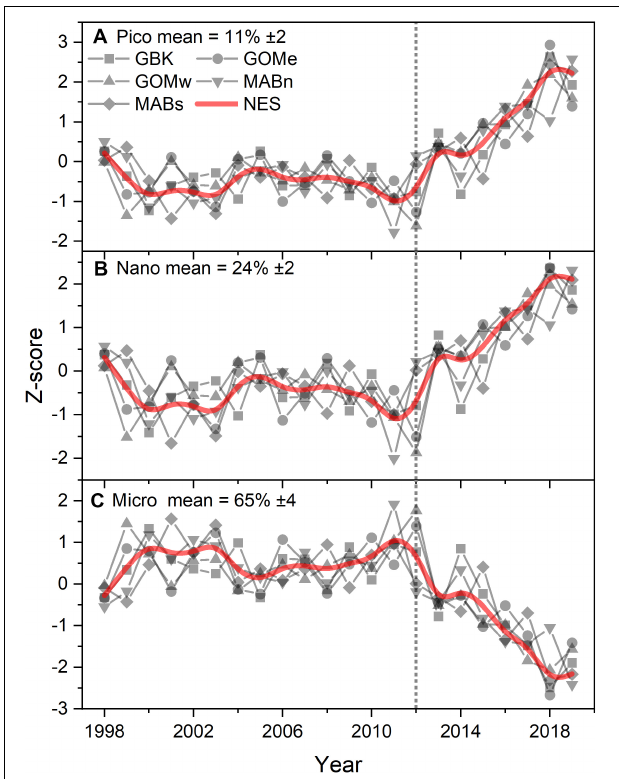
FIGURE 4 | Z-score of estimated phytoplankton size fractional contribution percentage of pico (A) , nano (B) , and micro (C) plankton to total chlorophyll for the Northeast Shelf (NES) and NES subareas (NES, GBK, GOMe, GOMw, MABn, and MABs). The mean percentage for each size class shown in the panel title with ± 1 SD; the NES time series is shown as a b-spline; 2012 is highlighted with vertical dotted